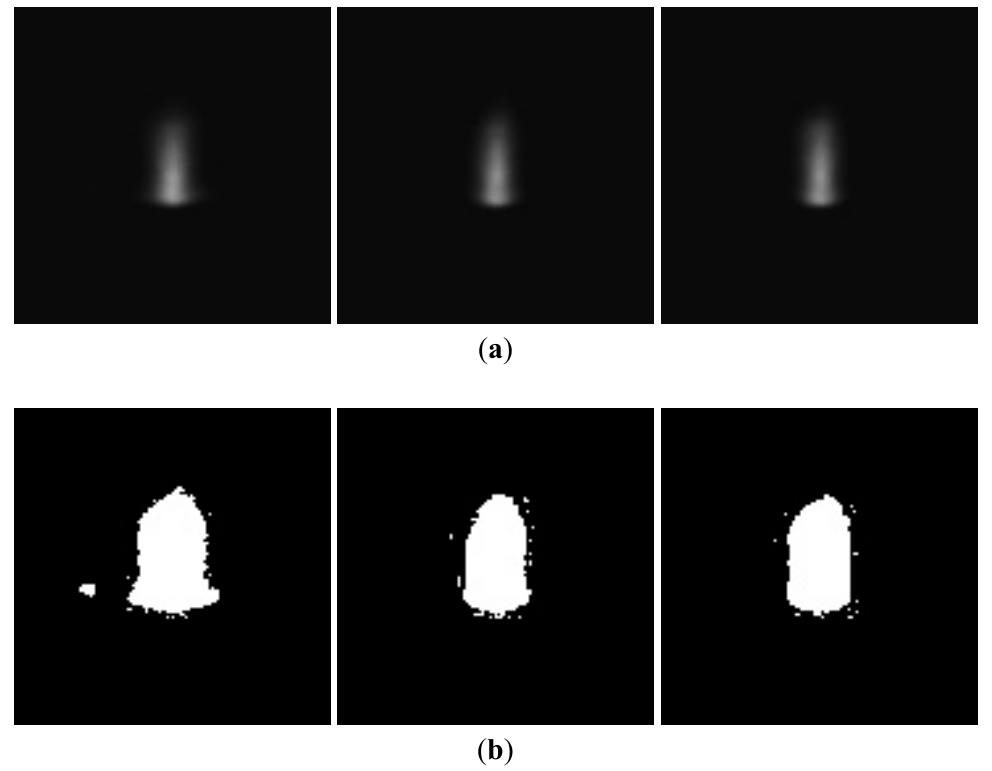
Figure 3. Plasma region of image of SS 420 ( a ) acquired by CMOS camera and ( b ) after